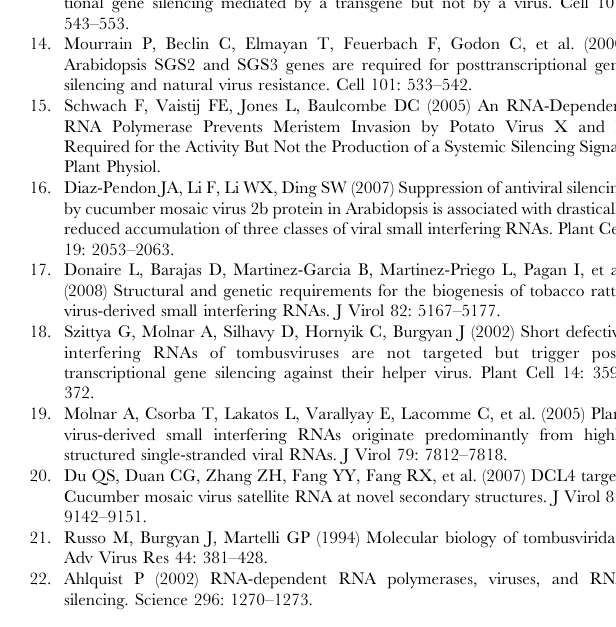
Figure S5 Simulation of the effect of sequencing errors on positive and negative strand vsiRNAs. The effect of sequencing errors on positive and negative strand vsiRNAs was simulated by applying sequencing errors at different rates (1 error in 1000, 100 or 10 sequences) on perfectly matching positive and negative strand vsiRNAs (either redundant or non-redundant sequences). The ratio of perfectly matching sequences to those matching with 0 or 1 mismatch was calculated. We found a similar effect on the positive and negative strand vsiRNAs when redundant reads were used but a much more pronounced effect on the positive strand vsiRNAs when the simulation was applied to non-redundant reads. Figure S6 Comparison of 454 and Solexa profiles of vsiRNAs. Profiles of vsiRNA obtained by the 454 and Solexa platforms are shown on the top of each other. Red and blue lines represent 454 and Solexa profiles, respectively. Figure S7 Nucleotide distributions in vsiRNAs 5 9 end. First nucleotides of vsiRNAs obtained through Solexa sequencing of the four small RNA libraries were analysed for each size category (18– 24 nucleotides). The top four and bottom panels show the result for all reads and hot spots, respectively. Figure S8 Separate Solexa profiles of 21 and 22 nt vsiRNAs. The 21 and 22 nt vsiRNAs were separated from the Solexa datasets (wild type and mutant virus), and their normalised number was plotted against the positions of nucleotides in the viral genome. Short RNAs were sequenced from wild type (G11) or silencing protein disabled (19) virus infected N. benthamiana